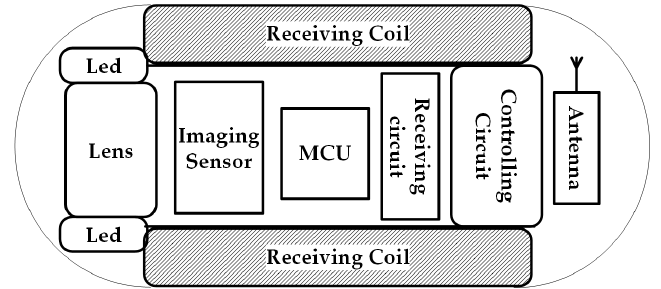
Figure 1. Overview of modules of a wireless capsule endoscope (WCE).